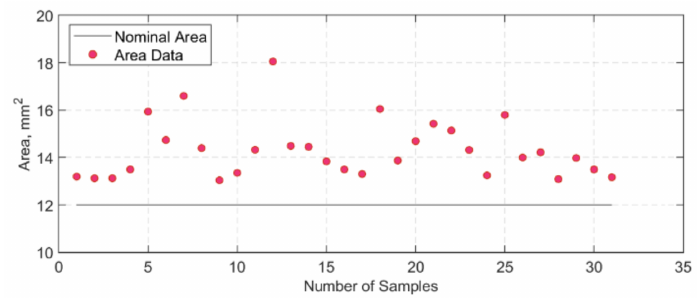
Figure 9. Area values of each sample, after analysis in